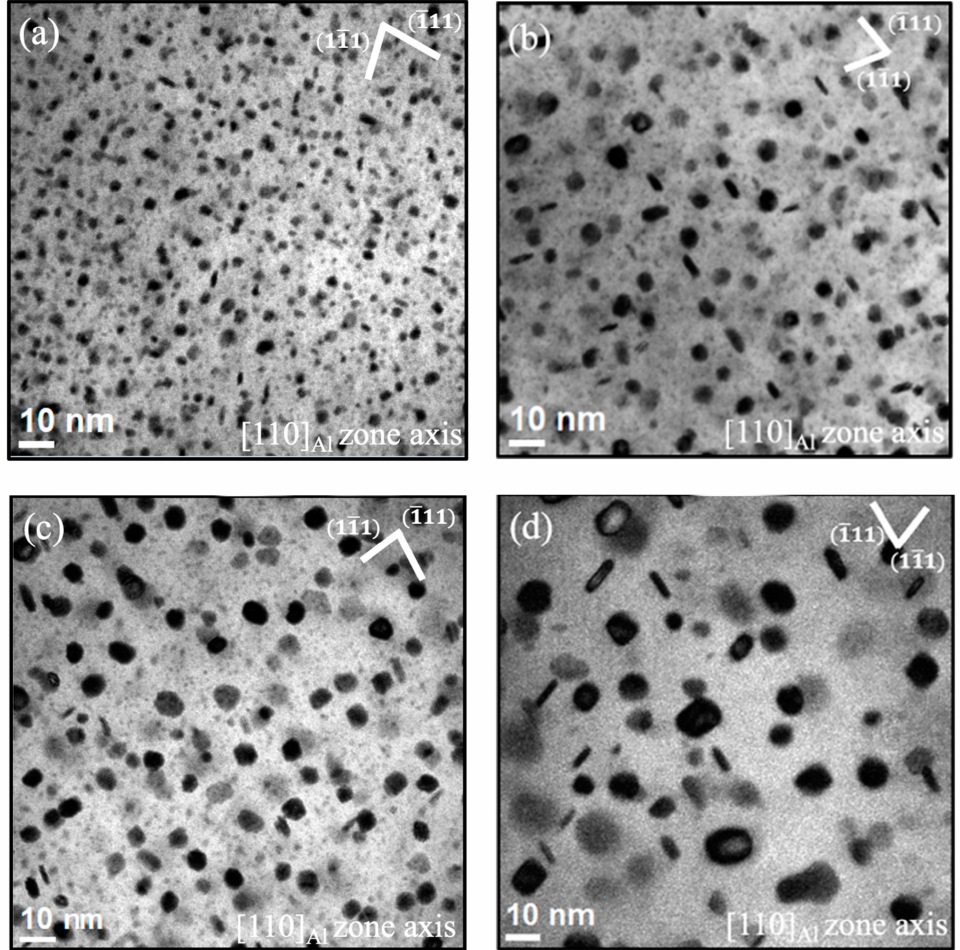
Figure 4. TEM images of η (cid:48) precipitates of 7075-LCu obtained from the PA conditions at ( a ) 100 ◦ C, ( b ) 120 ◦ C, ( c ) 140 ◦ C, and ( d ) 160 ◦